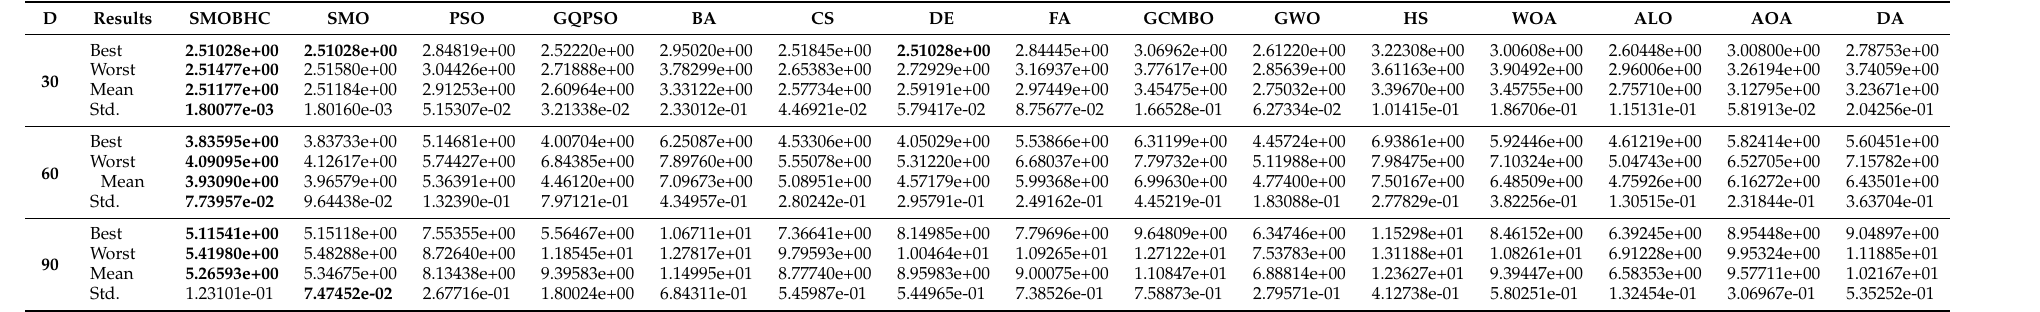
Table 5. Experimental results obtained for the fifteen experimented algorithms relative to three different problem dimensions equal respectively to 30, 60, and 90 for the second battlefield composed of thirty threats.